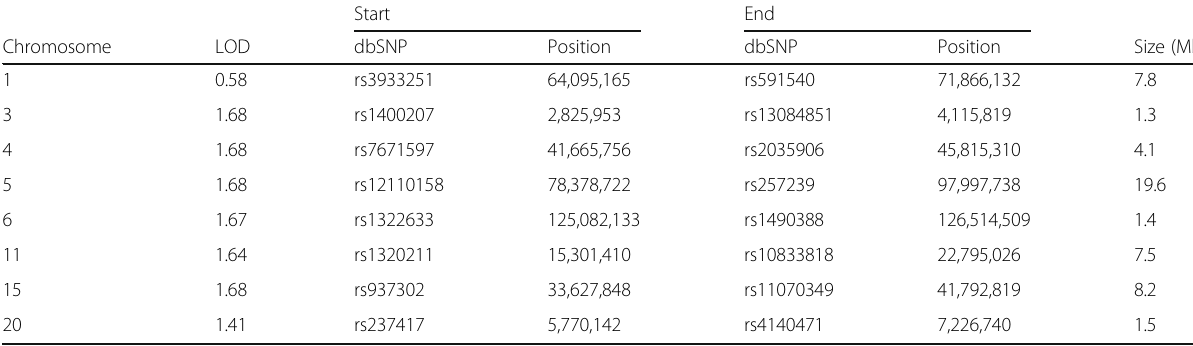
Table 1 R2100 Multipoint Linkage Analysis